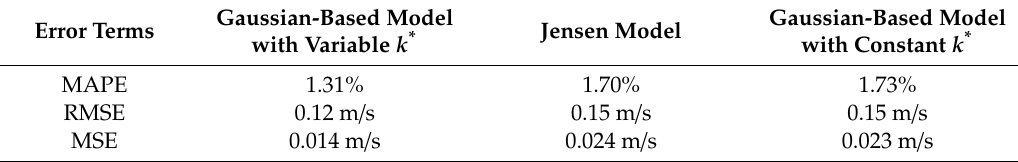
Figure 14. Comparison of sitewide average wind speed prediction from 100 selected cases: ( a ) boxplot of the percent error of sitewide average wind speed prediction using three different methods; ( b ) histogram of the percent error of sitewide average wind speed prediction using the Gaussian-based model with variable k ∗ ; and ( c ) histogram of the percent error of sitewide average wind speed prediction using the Jensen model. Table 2. Models’ sitewide averaged wind speed prediction errors in 100 selected cases.